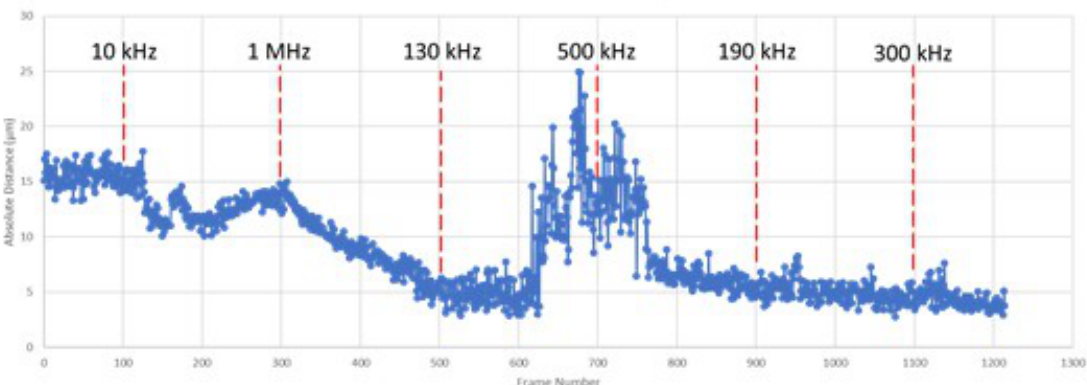
Figure 7. Average absolute distance from center by frame (Trial 2).